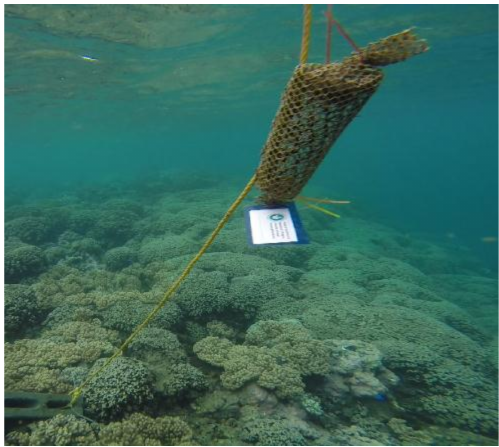
Figure 4. Deployed algae cage containing a single H. pannosa